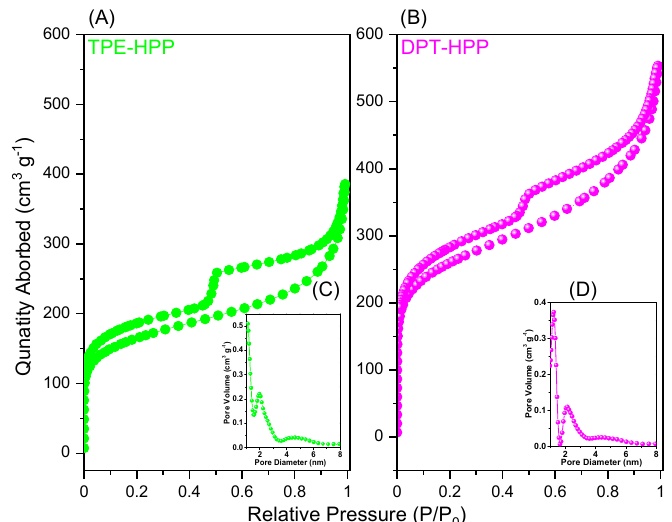
Figure 5. N 2 adsorption / desorption isotherms of ( A ) TPE-HPP and ( B ) DPT-HPP. Pore size distribution curves of ( C ) TPE-HPP and ( D ) DPT-HPP.